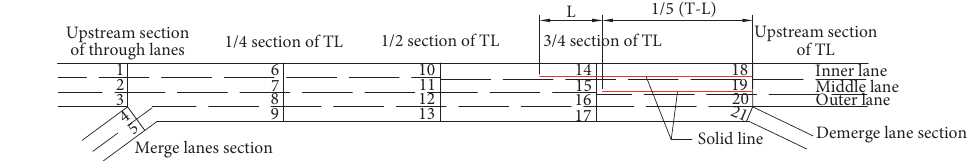
Figure 6: Schematic diagram of weaving area optimization.